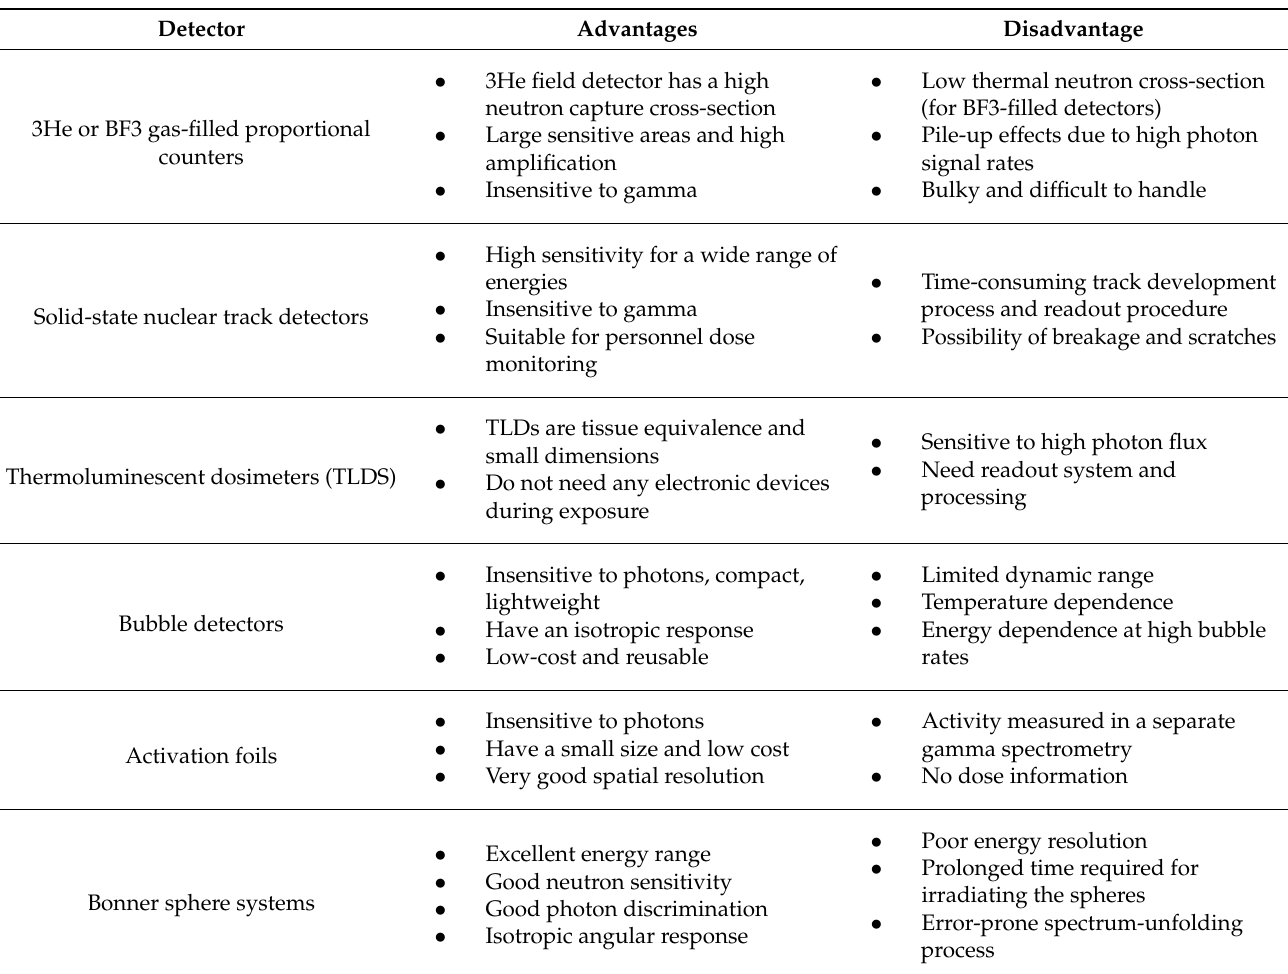
Table 4. Summary of the common neutron detector used for secondary neutron measurements in